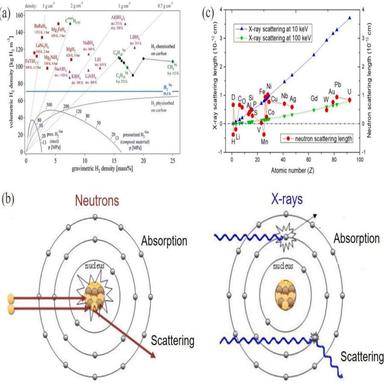
(a) The gravimetric and volumetric hydrogen densities of some selected hydrides; (b) The comparison graph for interaction of neutron and X-ray with an atom; (c) Comparison of neutron scattering lengths and X-ray scattering lengths (10 keV and 100 keV) of some selected elements.